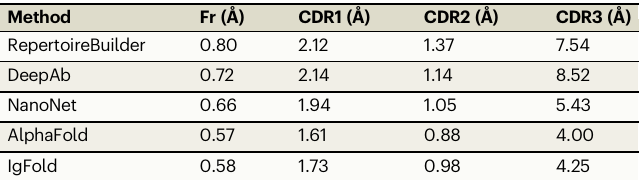
Table 2 | Accuracy of predicted nanobody